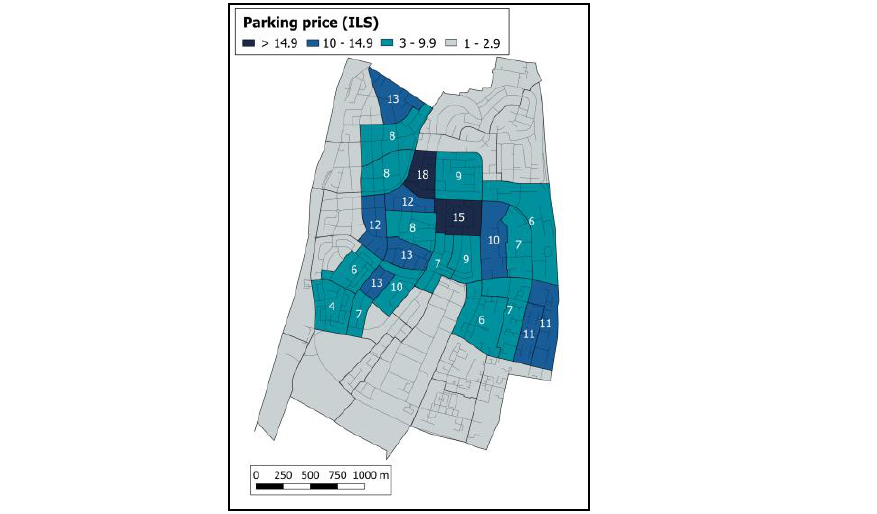
Figure 11. Equilibrium parking prices, in ILS, for 85% occupation threshold based on Bat Yam’s 42 transportation analysis zones (TAZ) as pricing